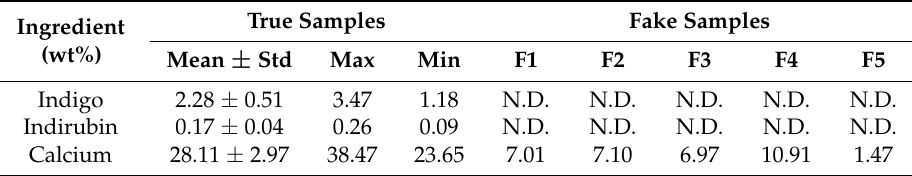
Table 1. Contents of some marker components in true and fake Indigo Naturalis.